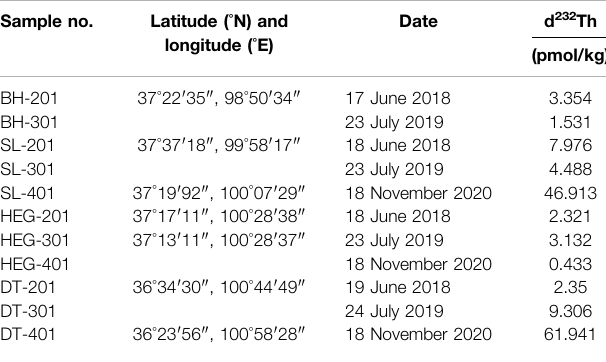
TABLE 5 | Seasonal changes of 232 Th content in the exogenous rivers of Qinghai Lake. Sample